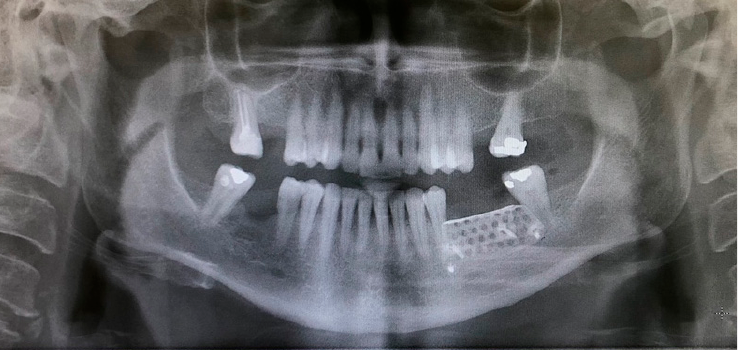
Figure 7. Post-operative orthopantomography.